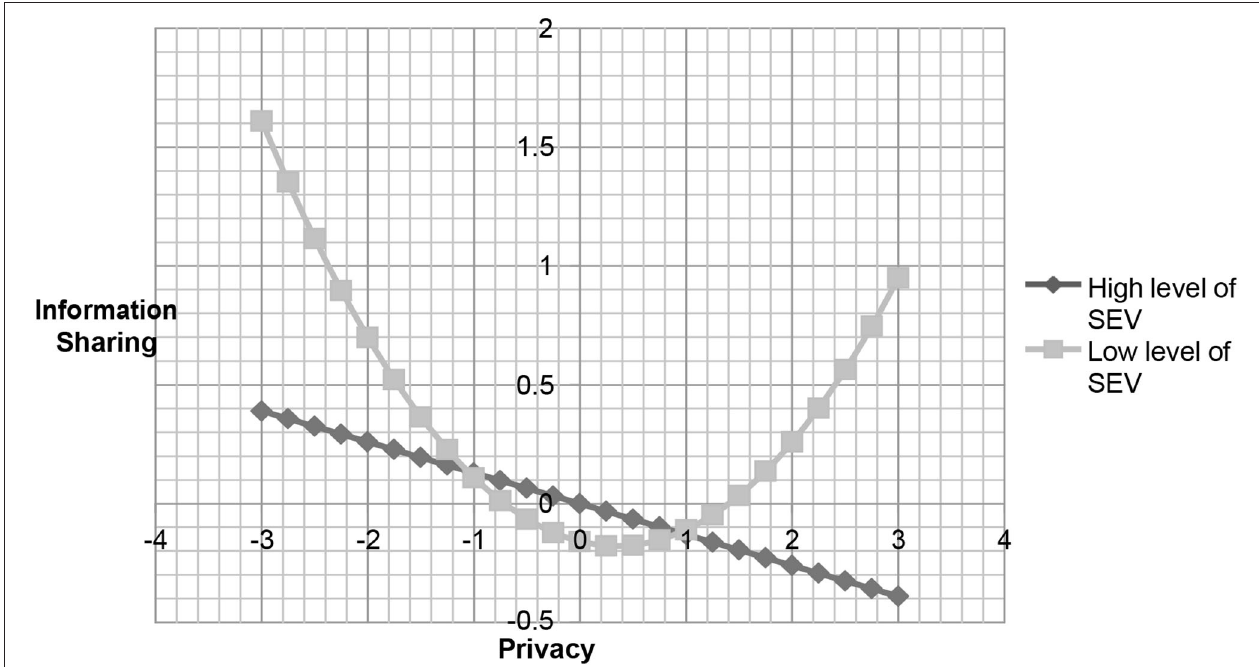
FIGURE 2 | The relationship between privacy concern and information sharing under different level of system evaluation variables.